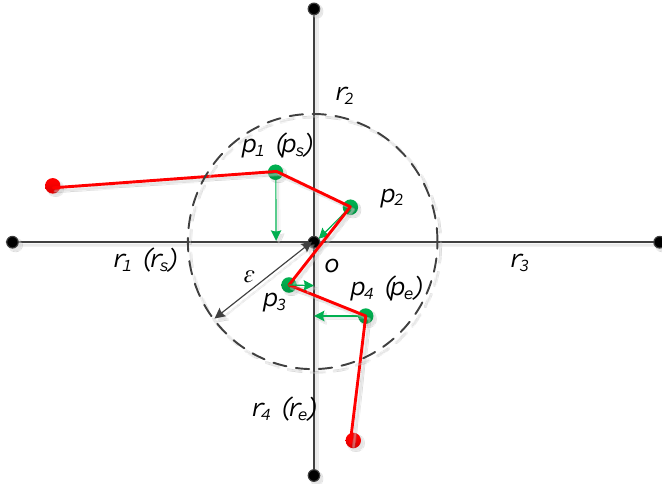
Figure 3. Classification and matching of intersection trajectory points. There are four road sections, r 1 , r 2 , r 3 , r 4 , which are connected in an intersection o . r 1 is the inbound road sections ( r s ) and r 4 is outbound road sections (r e ). { p 1 , p 2 , p 3 , p 4 } are the intersection trajectory points. p 1 and p 4 are the inbound point ( p s ) and outbound point ( p e ),